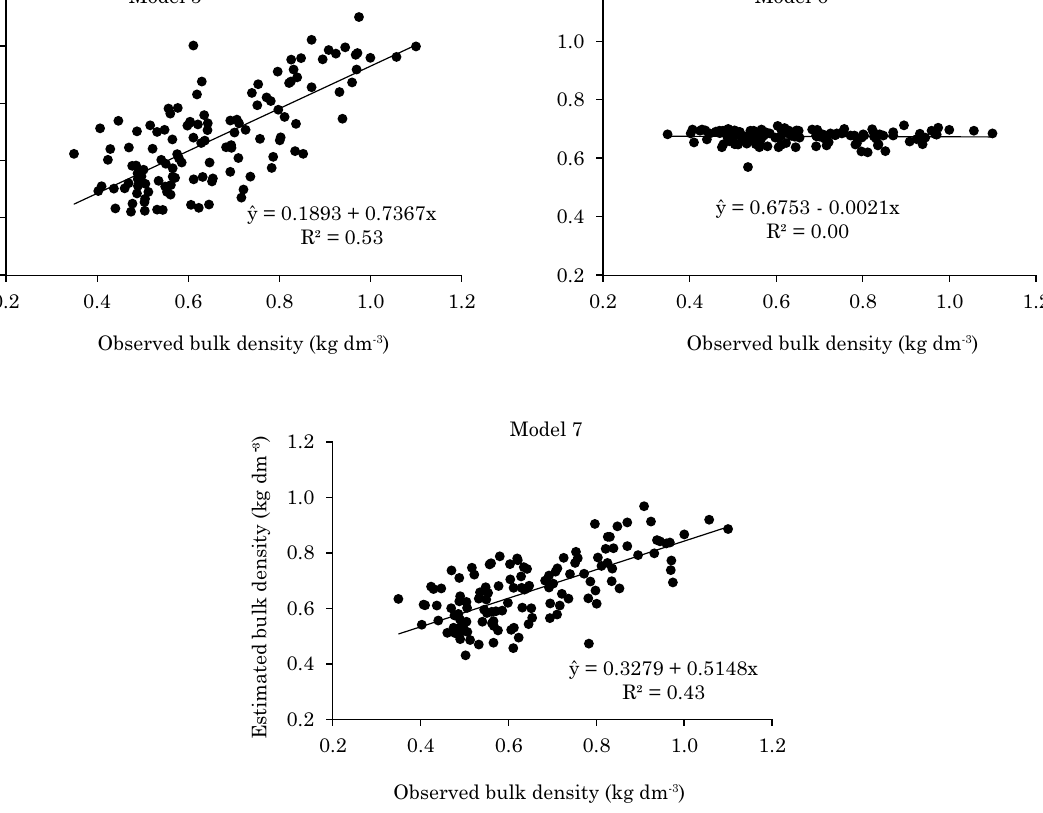
Figure 2. Validation of the regression models generated by the stepwise method for predicting soil density.